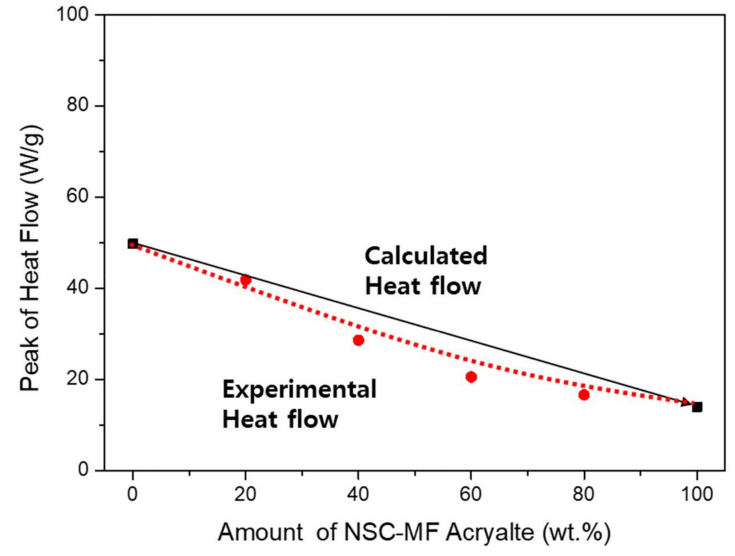
Figure 12. Peak of heat flow for the blended system of NSC-MF acrylate and